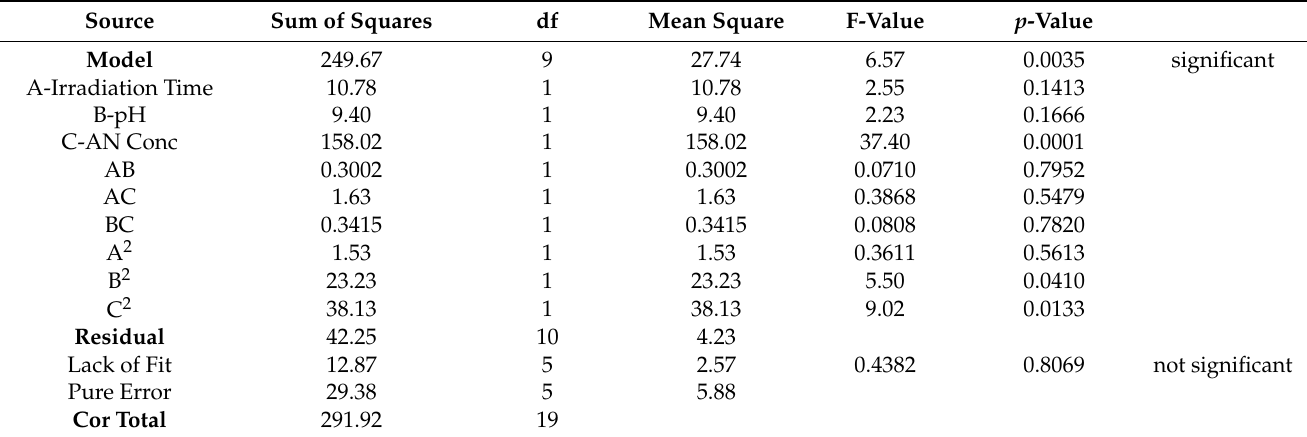
Table 3. ANOVA for quadratic